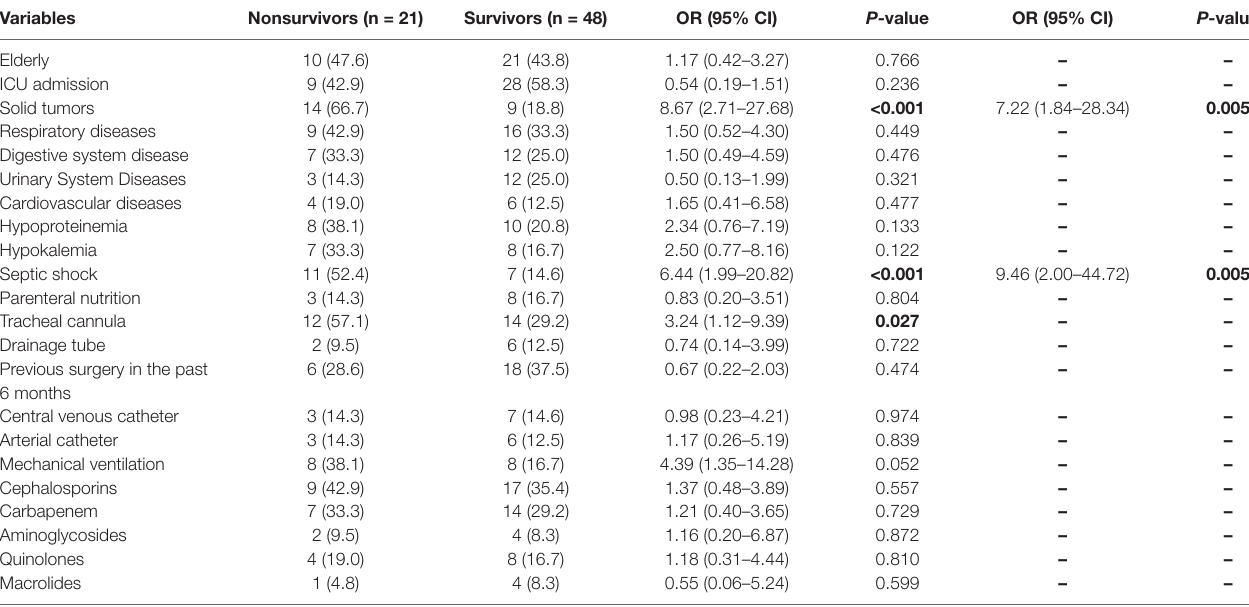
TABlE 5 | Risk factors associated with 28-day